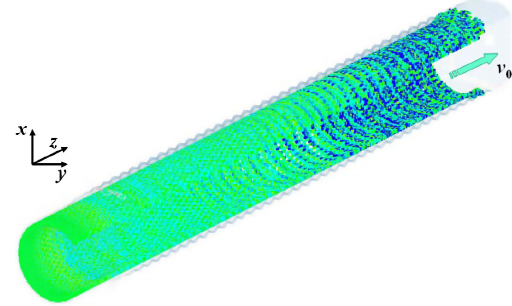
FIG. 10. Results of CST PIC simulations of the electron beam dynamics in the SWO realized at the SATURN accelerator (the